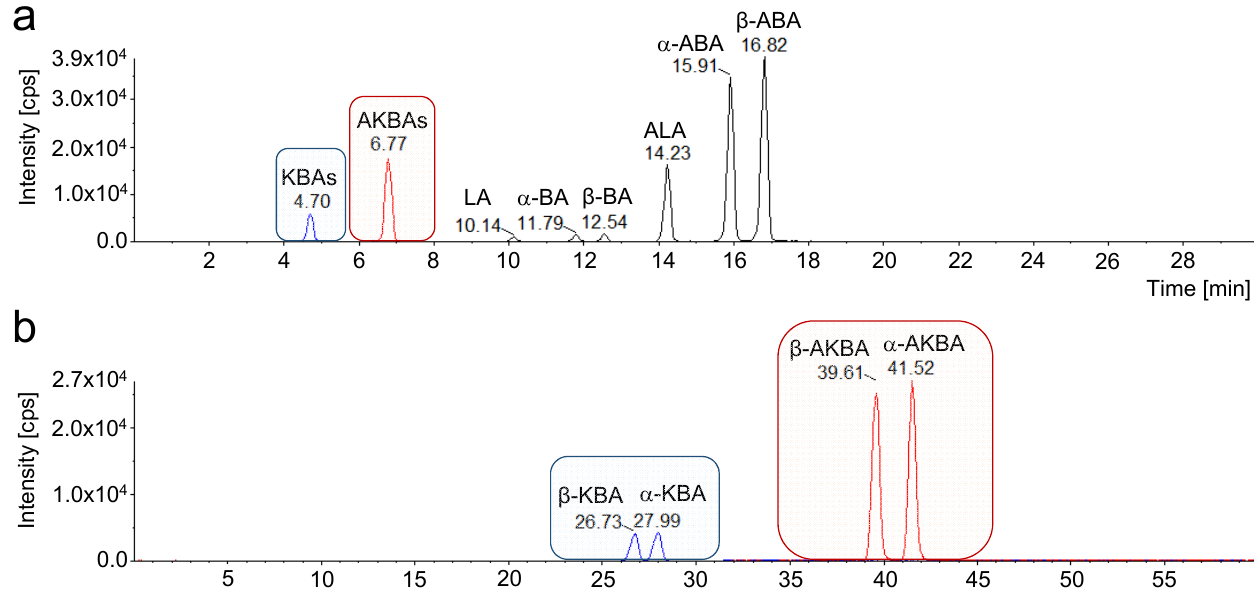
Figure 5. Chromatographic separation of 11-keto-boswellic acids with different stationary phases. ( a ) Multiple reaction monitoring (MRM) chromatogram using a C18 stationary phase. The constitutional isomers lupeolic acid (LA), α -boswellic acid ( α -BA), and β -boswellic acid ( β -BA), as well as acetyl-lupeolic acid (ALA), acetyl- α -boswellic acid ( α -ABA), and acetyl- β -boswellic acid ( β -ABA), could be separated sufficiently. However, it is not possible to separate the constitutional isomers of 11-keto-boswellic acid (KBAs) and acetyl-11-keto-bowellic acid (AKBAs) under these conditions [5]. ( b ) MRM chromatogram using a pentafluorophenyl (PFP) stationary phase. The utilization of a PFP stationary phase and optimization of the chromatographic parameters by DoE enabled a successful separation and selective quantification of all KBAs and AKBAs isomers, namely 11-keto- α -boswellic acid ( α -KBA), 11-keto- β -boswellic acid ( β -KBA), acetyl-11-keto- α -boswellic acid ( α -AKBA), and acetyl-11-keto- β -boswellic acid ( β